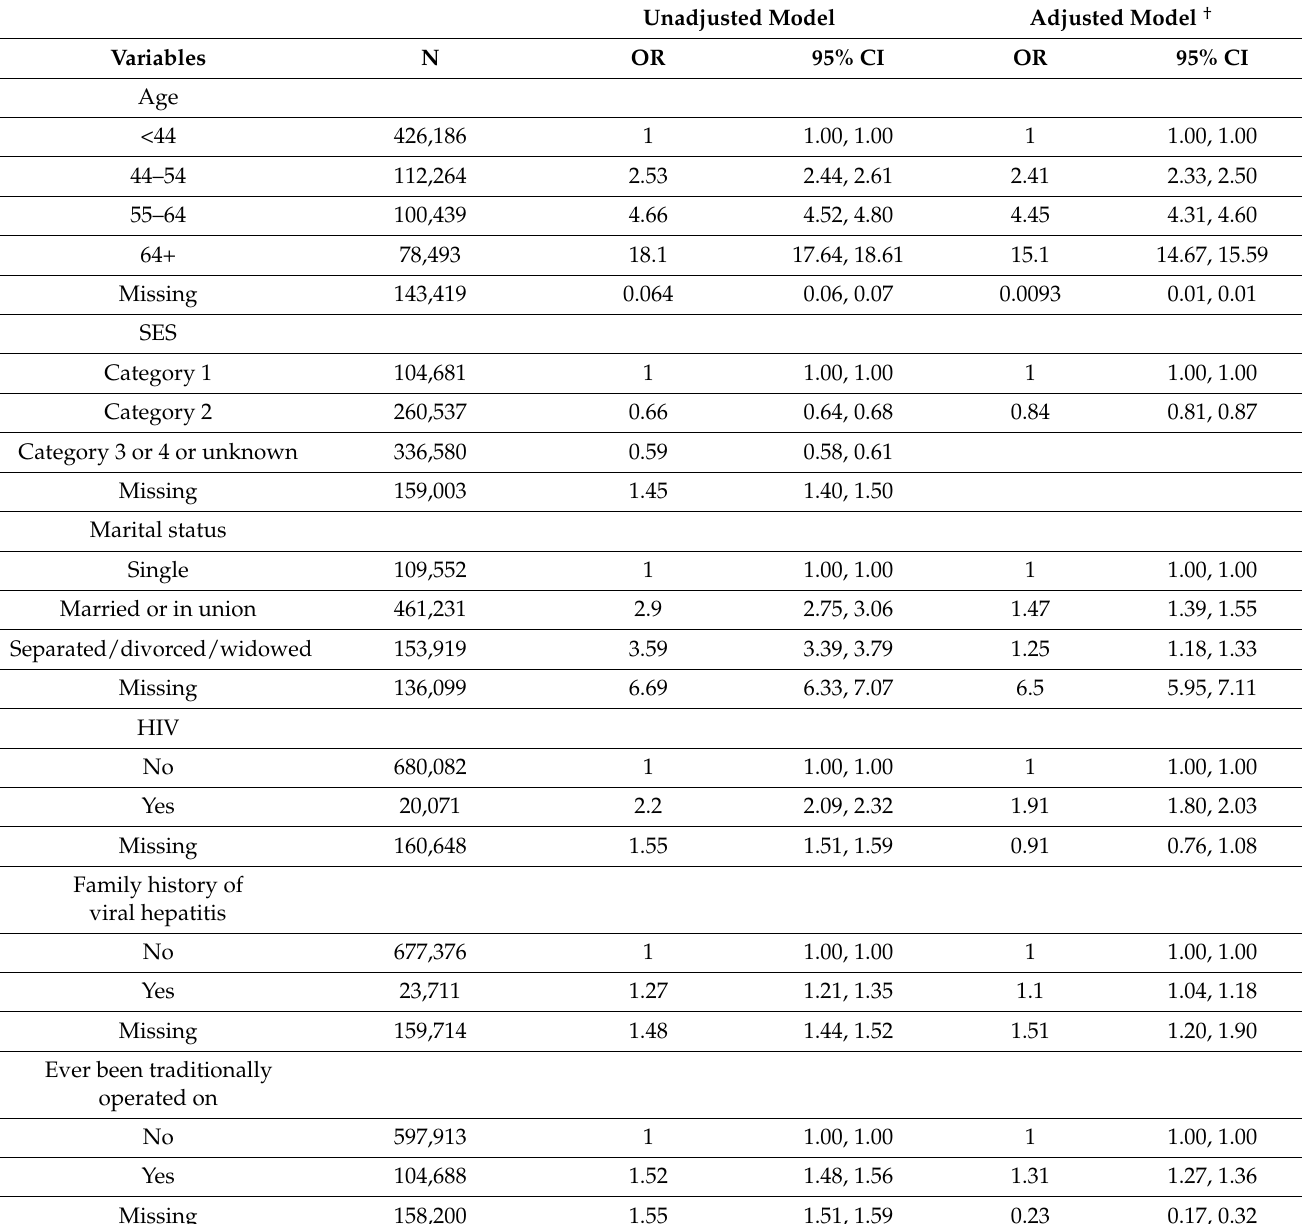
Table 3. Unadjusted and adjusted associations between anti-HCV seroprevalence and socio-economic, demographic, clinical, and behavior